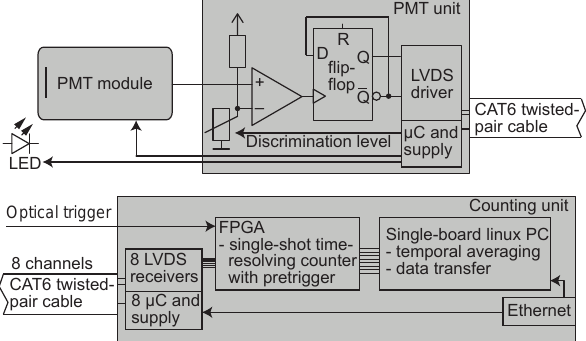
Figure 5. Scheme of the eight-channel photon-counting system (CNT80). Each PMT and the discrimination electronics are con- structed as a fixed unit (top panel). The photon pulses from a max- imum of eight detector units are then digitally transferred to the counting unit (bottom panel) where the lidar return signals are pro- cessed, averaged, and can be obtained by the measurement PC via an Ethernet